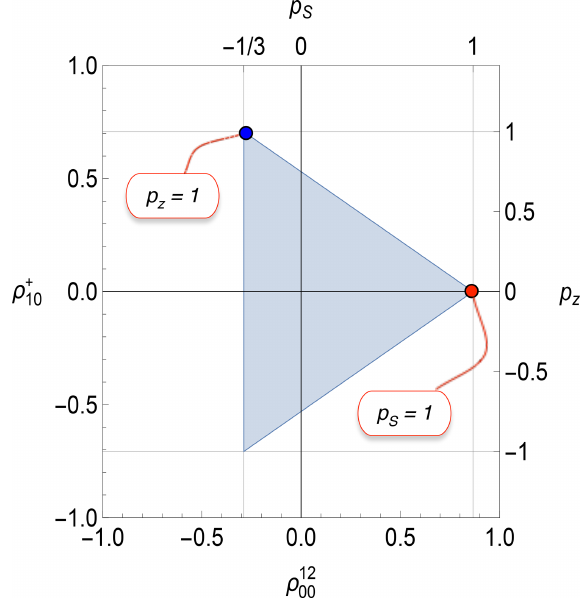
Figure 4. Physical bounds on the rank-0 polarization moment ρ 12 00 and the rank-1 polarization moment ρ + for spin-1/2 pairs. The cor- 10 responding values of the z polarization p z and singlet polarization p S are also shown. The singlet polarization p S (top horizontal axis) and rank-0 polarization moment ρ 12 (lower horizontal axis) are re- 00 lated through Eq. (21). The shaded triangle shows the physically accessible region. The annotations show the vertices for exclusive population of the singlet state (red) and for maximal z polarization (blue). Note that complete z polarization is accompanied by singlet polarization of p S = − 1 /